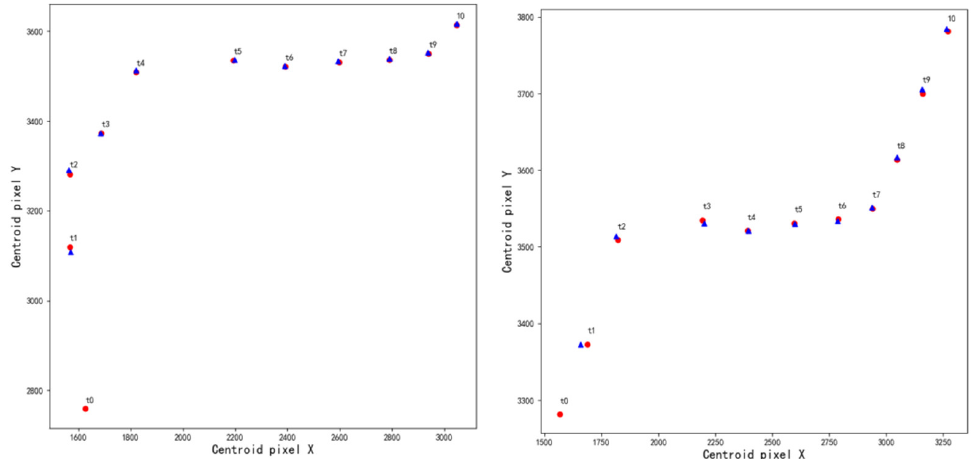
Figure 13. Comparison of the prediction of different cloud centroids at two times and corresponding real longitude and latitude.